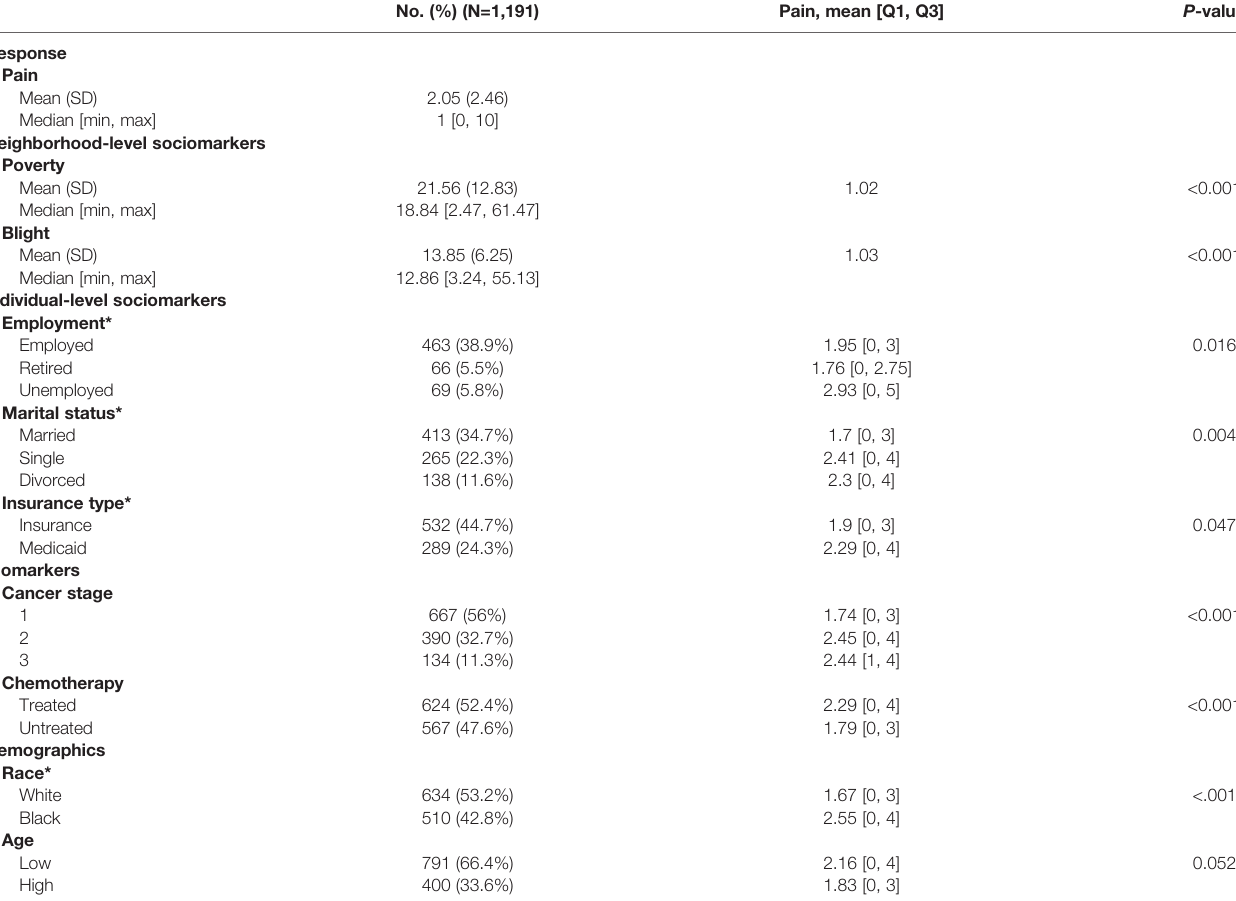
TABLE 1 | Baseline characteristics related to pain intensity (nonparametric rank